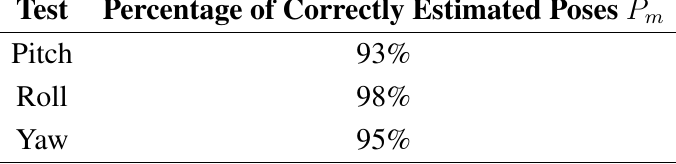
Table 9. Robustness of the pose imitation.